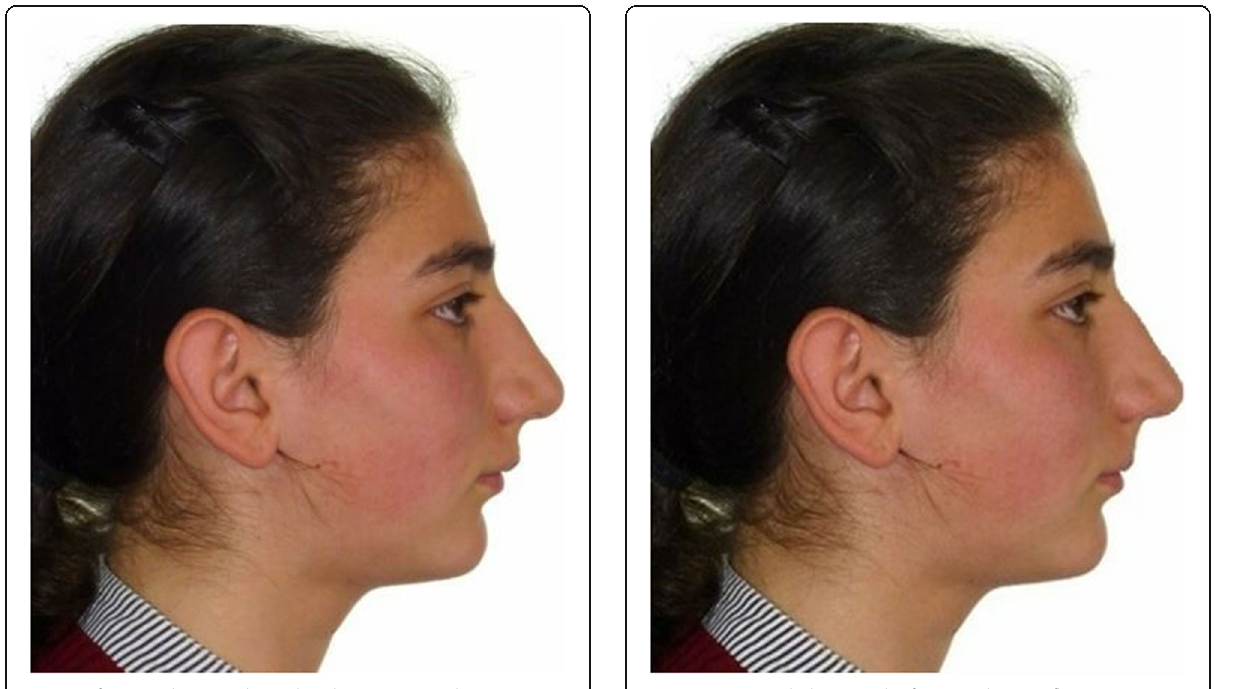
Fig. 1 Reference photograph used in the present study Fig. 2 Constructed photograph after virtual camouflage